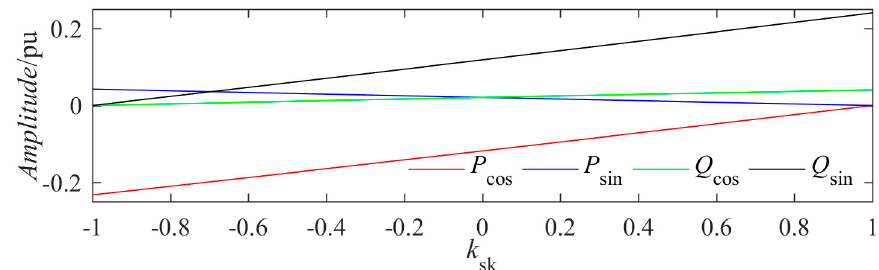
Figure 4. An example to show the relationships between P gsin2 , P gcos2 , Q gsin2 , Q gcos2 and k sk .